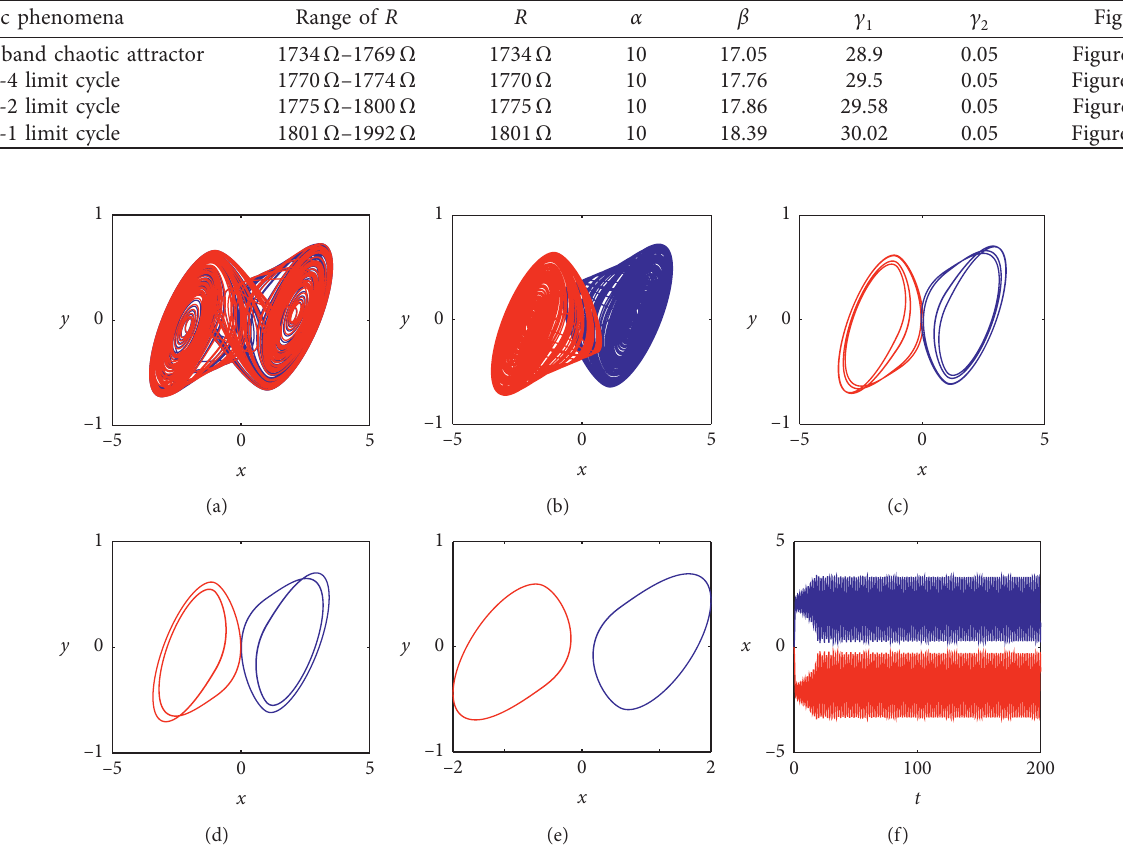
and the initial conditions are 0 , 0 . 1 , 0 , 0 􏼂 􏼃 and 1